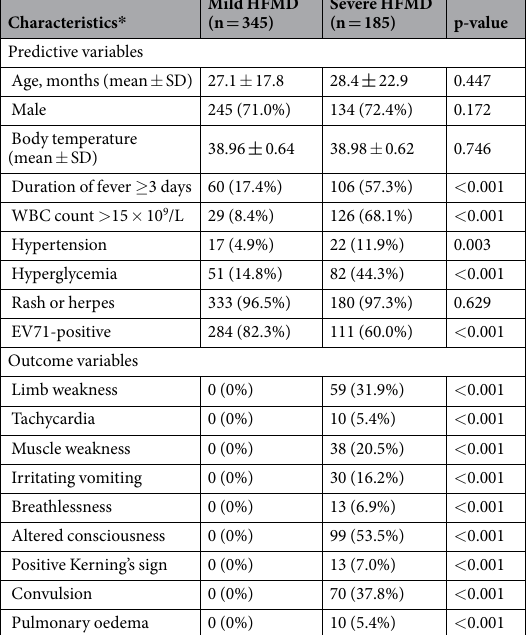
Table 1. Comparison of demographic and clinical data between mild HFMD and severe HFMD patients. HFMD = Hand-Foot-Mouth Disease; * Except where otherwise indicated, values are the number of patients (percentage) of patients with the